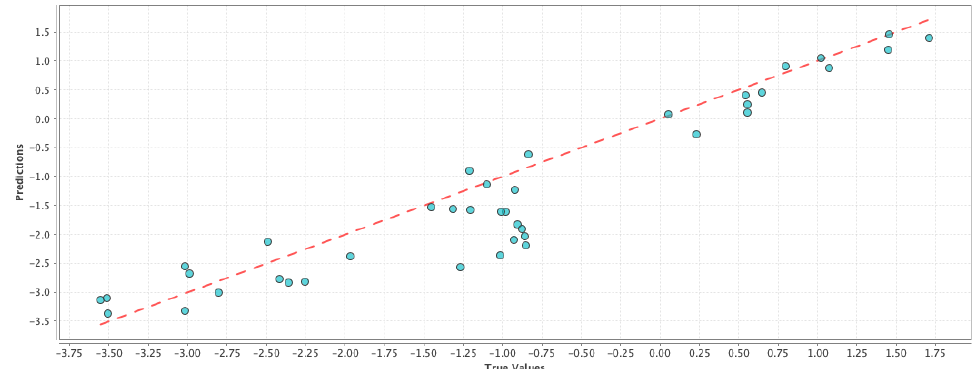
Figure 2. Same as Figure 1 but for Support Vector Machine model.